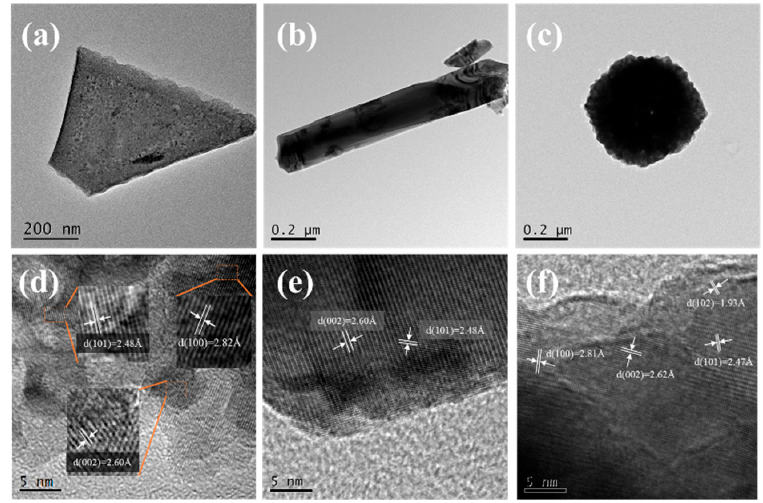
Figure 4. ( a – c ) TEM images of three ZnO samples. ( d – f ) HRTEM images of three ZnO samples.